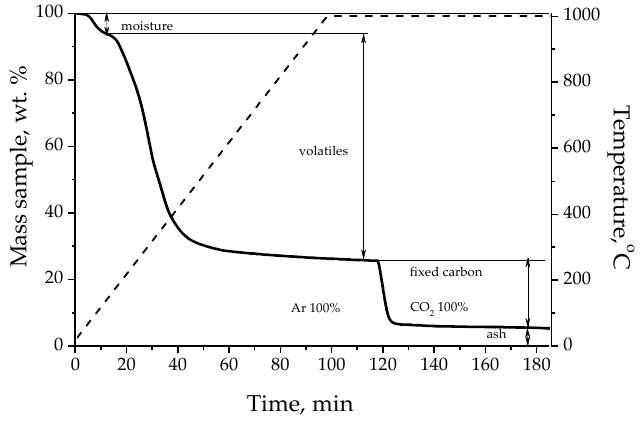
Figure 2. TG and DTG curves corresponding to the pyrolysis of RPC.